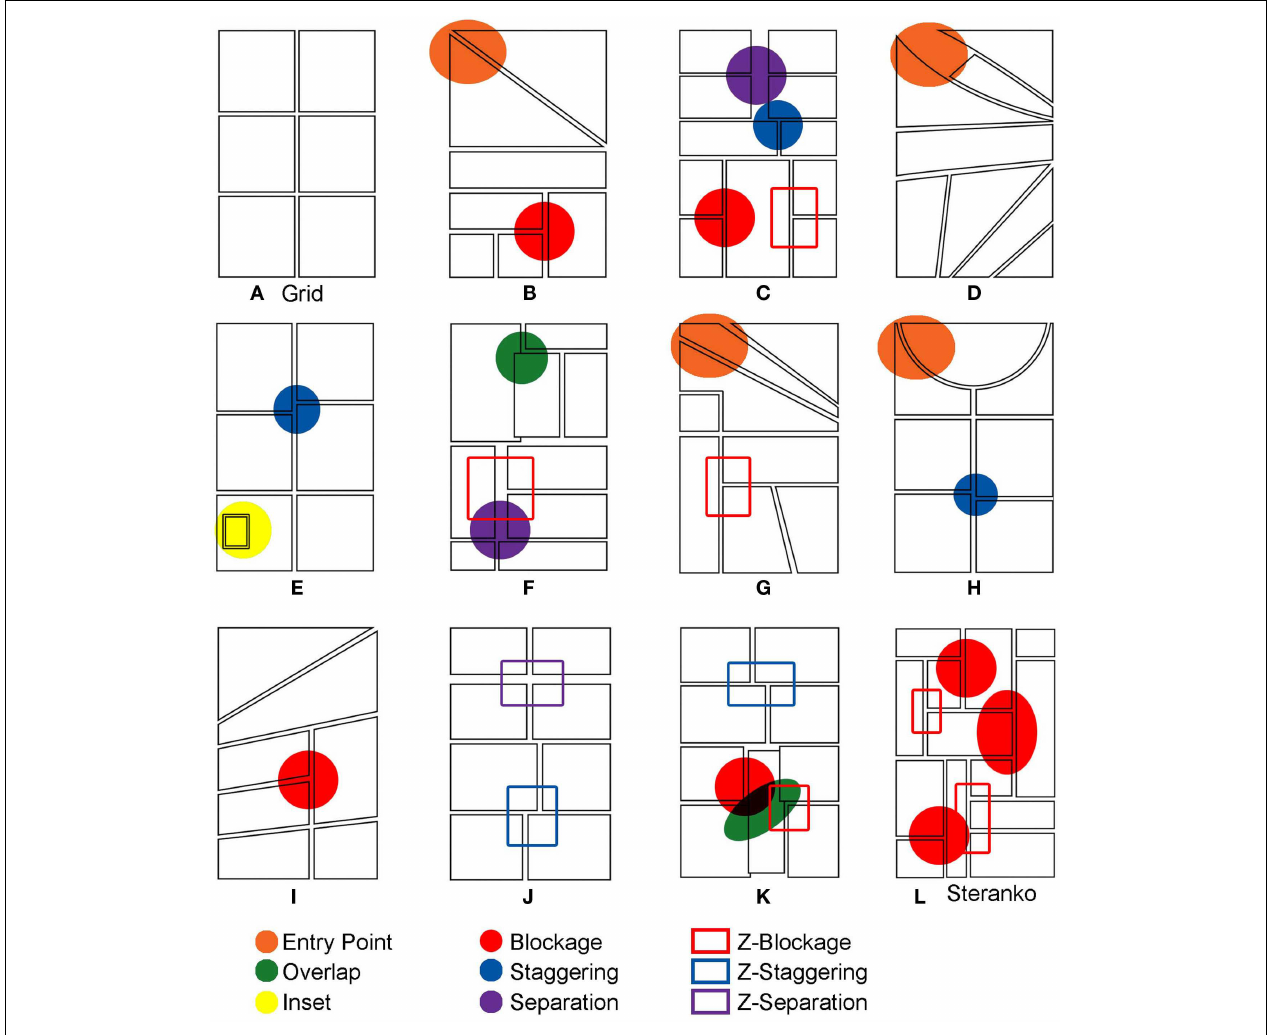
FIGURE 3 |All stimuli pages with notations of the various ECS